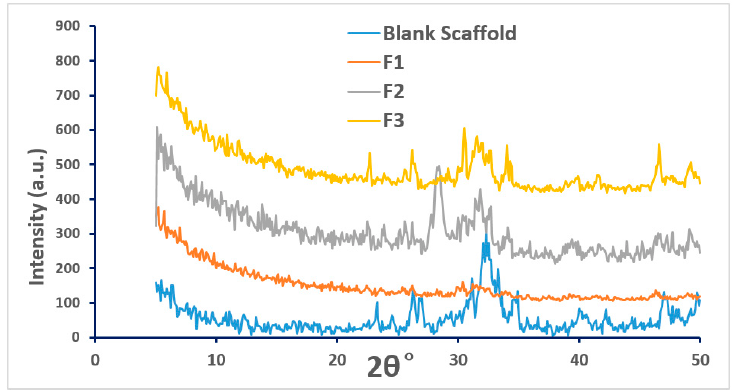
Figure 6. XRD data of blank scaffold (uncoated) and coated scaffolds: F1 (coated with 5-FU), F2 (coated with 5-FU and Soluplus, F3 (coated with 5-FU, Soluplus and PEG